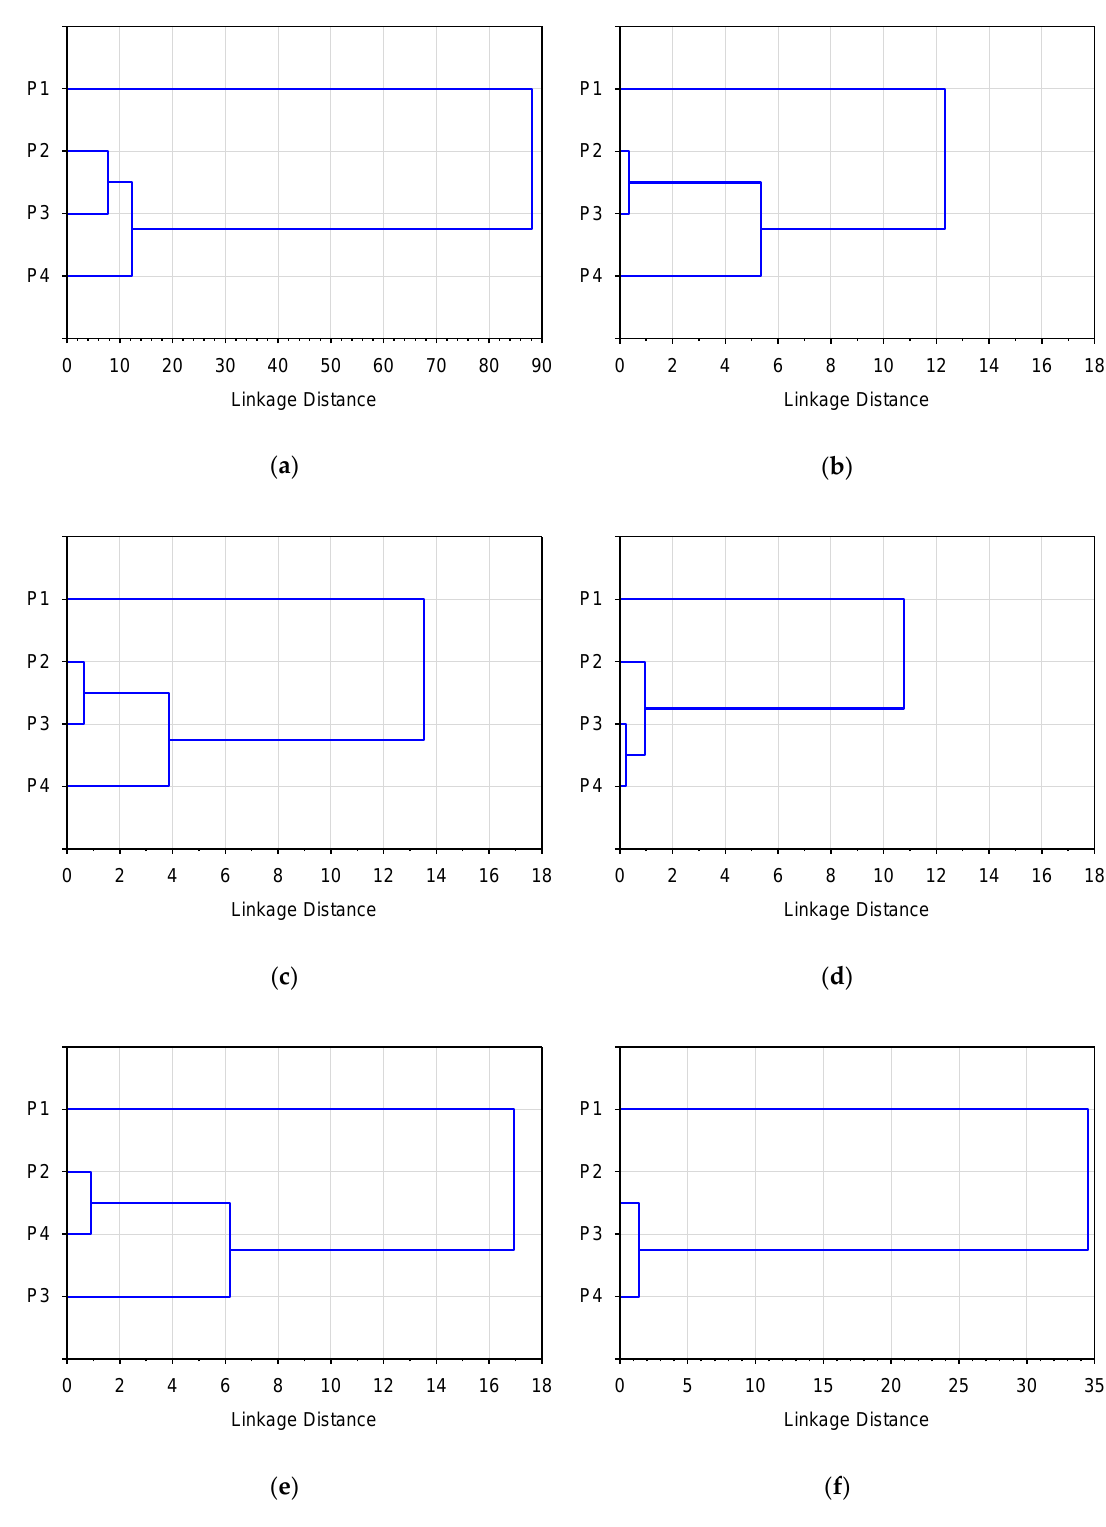
Figure 3. Dendrograms (Ward’s Method—Square of Euklidean Distance) showing similarity of surface water quality examined in individual measurement-control points, taking into account the values of ( a ) all examined physicochemical indicators, ( b ) physical and acidification indicators, ( c ) oxygen indicators, ( d ) phosphorus indicators, ( e ) nitrogen indicators, ( f ) salinity indicators. Two clusters (cut-off level 2), including one three-element cluster consisting of P2 – P4 points located on the Chechło river and one - element cluster on the Mło szówka stream (Figure 3d), were